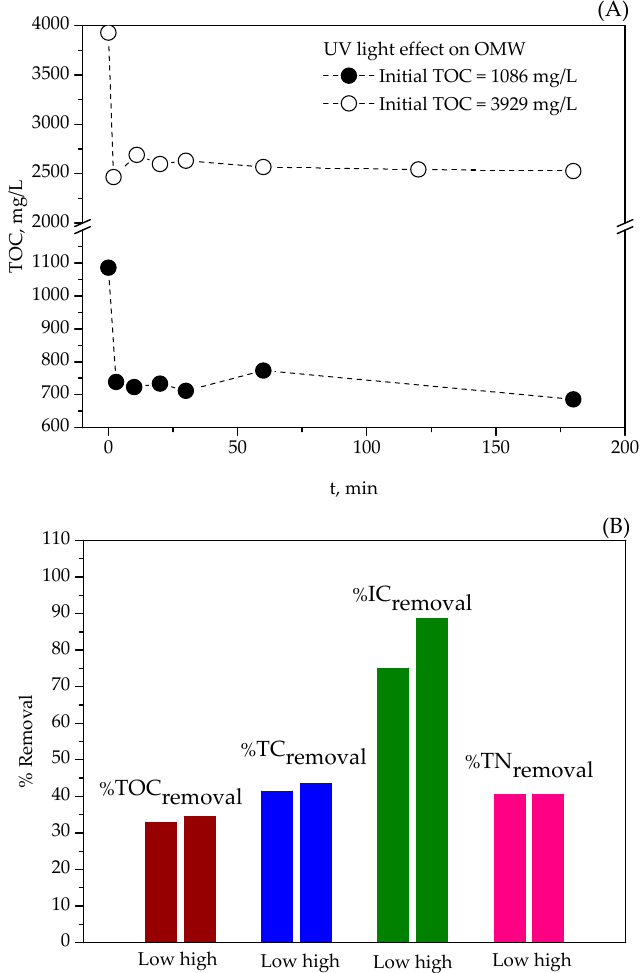
Figure 1. E ff ect of artificial ultraviolet light on the photodegradation of OMW (photolysis). ( A ) Variation of TOC value of two di ff erent OMW with high (Initial TOC = 3929 mg / L) and low (Initial TOC = 1086 mg / L) organic loads throughout the photodegradation. ( B ) Variation of the global removal percentages of TOC, TC, IC and TN parameters for OMW with di ff erent organic loads. Common operating conditions: pH = 3, T = 20 ◦ C and stirring speed = 150 rpm.